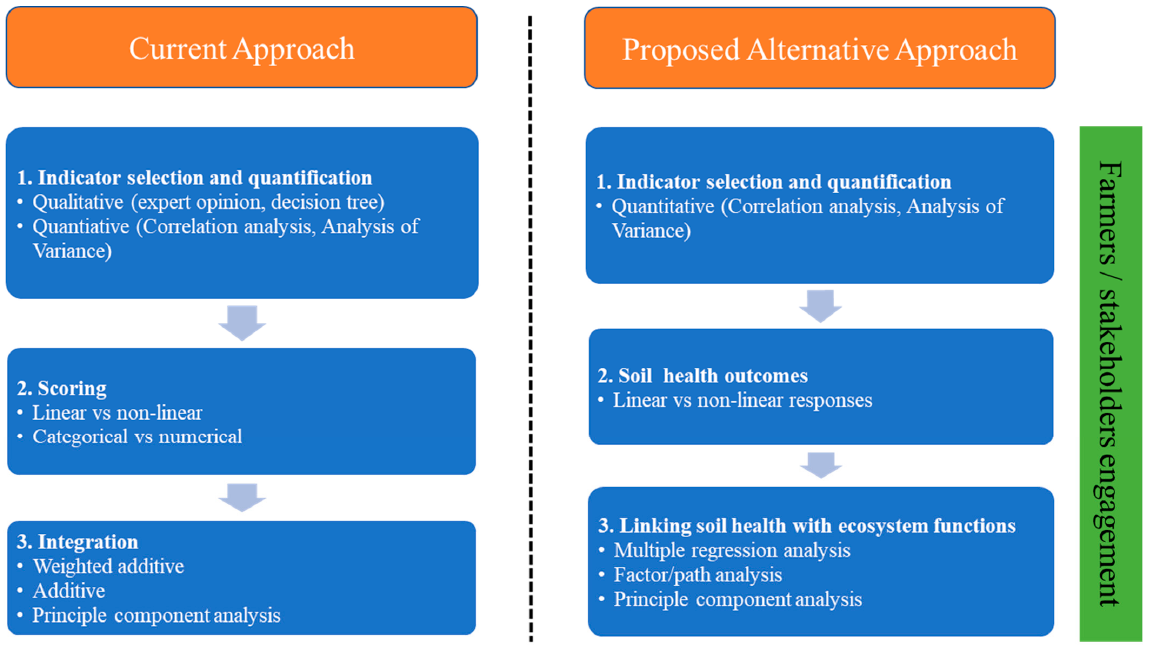
Figure 2. Current and proposed framework for soil health assessment in water-limited environ- ments.